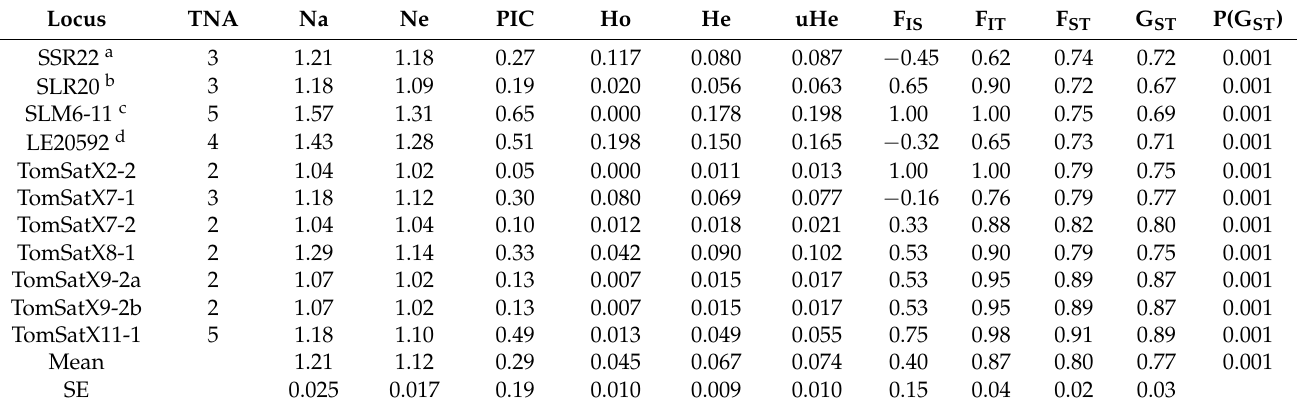
Table 2. Total number of alleles (TNA), number of different alleles (Na), effective number of alleles (Ne), polymorphism information content (PIC), observed heterozygosity (Ho), expected heterozygos- ity (He), unbiased expected heterozygosity (uHe), fixation indices (F IS , F IT and F ST ), and population differentiation (G ST , an analogue of F ST adjusted for bias) and its p -value (P(G ST )), for each SSR